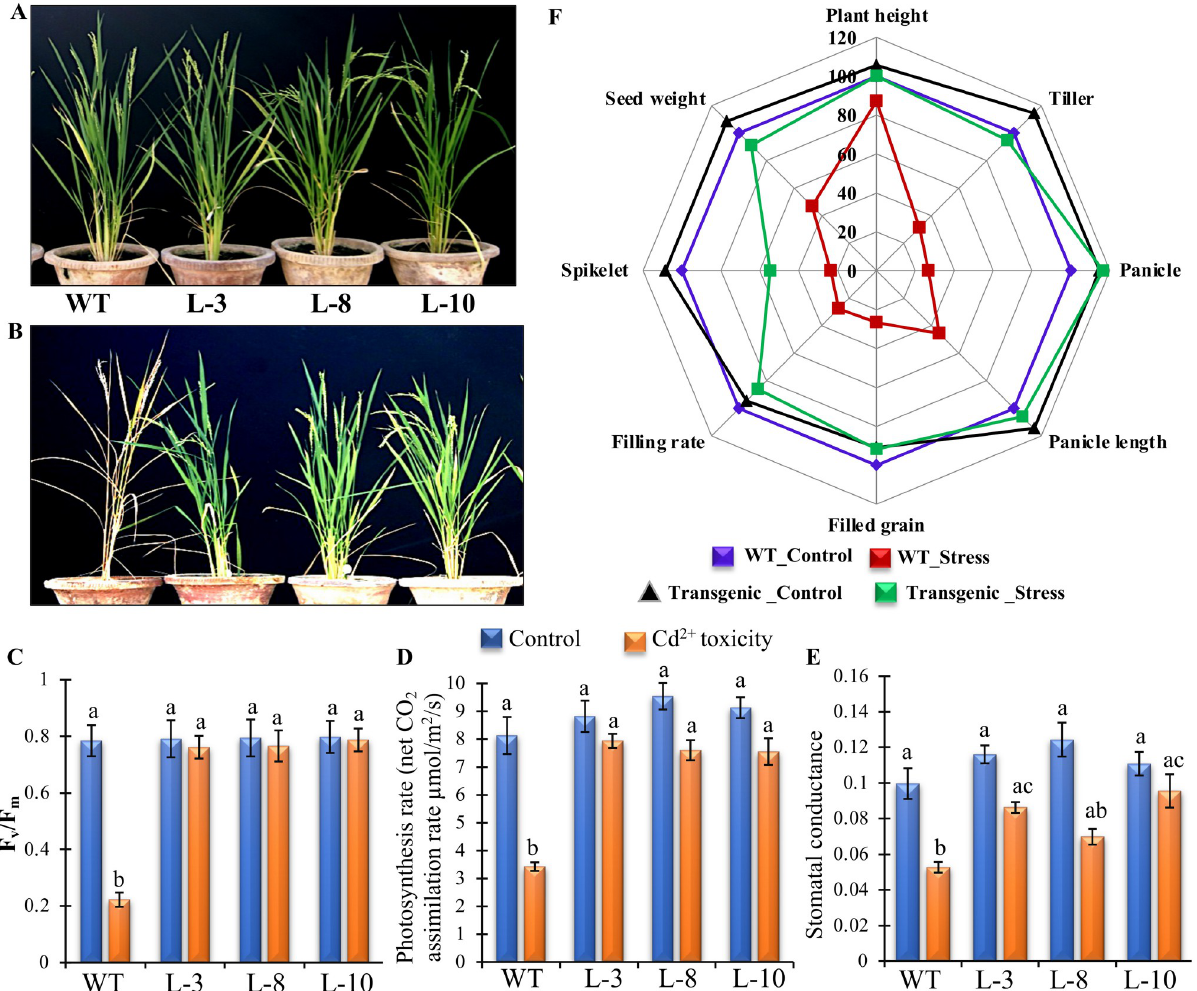
Fig 5. Photosynthetic and yield-related outcomes under Cd 2+ toxicity. Mature WT as well as PgGPx -transgenic plants grown in normal condition (A) or in presence 100 μ M CdCl 2 (B). Different photosynthetic parameters including photosystem II efficiency through Fv/Fm (C), rate of photosynthesis (D), and stomatal conductance (E) were measured for three independent transgenic lines and WT plants under control and Cd 2+ stress conditions. Data represent as mean value ± standard deviation of three biological replicates (n = 3). Different letters above the bar showed significant difference between the treatments and plant genotypes (P < 0.05, ANOVA; post hoc test). (F) Spider plots of different agronomic traits including plant height, tiller number, panicle number, panicle length, number of filled grain, grain filling rate, number of spikelets, and seed weight for PgGPx - overexpressing rice transgenic plants (average of three transgenic lines) were compared to the WT plants grown under normal and stress conditions. WT grown under control condition were considered as